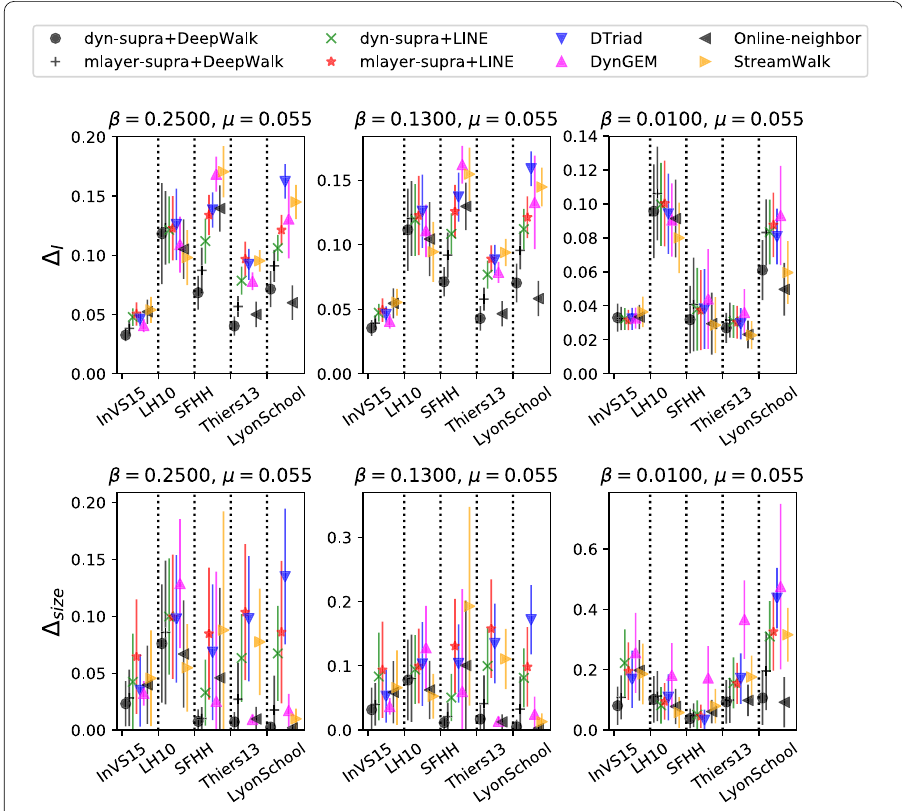
Figure 3 Prediction performance of each method in terms of epidemic impact, for each data set and for various β , at fixed μ = 0.055. The results at fixed β and for various μ are shown as a Supplementary Figure. The top and bottom row show respectively the cumulative discrepancy between the real and predicted epidemic curves (cid:4) I and the discrepancy between the final epidemic sizes (cid:4) size . Error bars give the standard deviation computed over the realizations of the SIR process and the embeddings